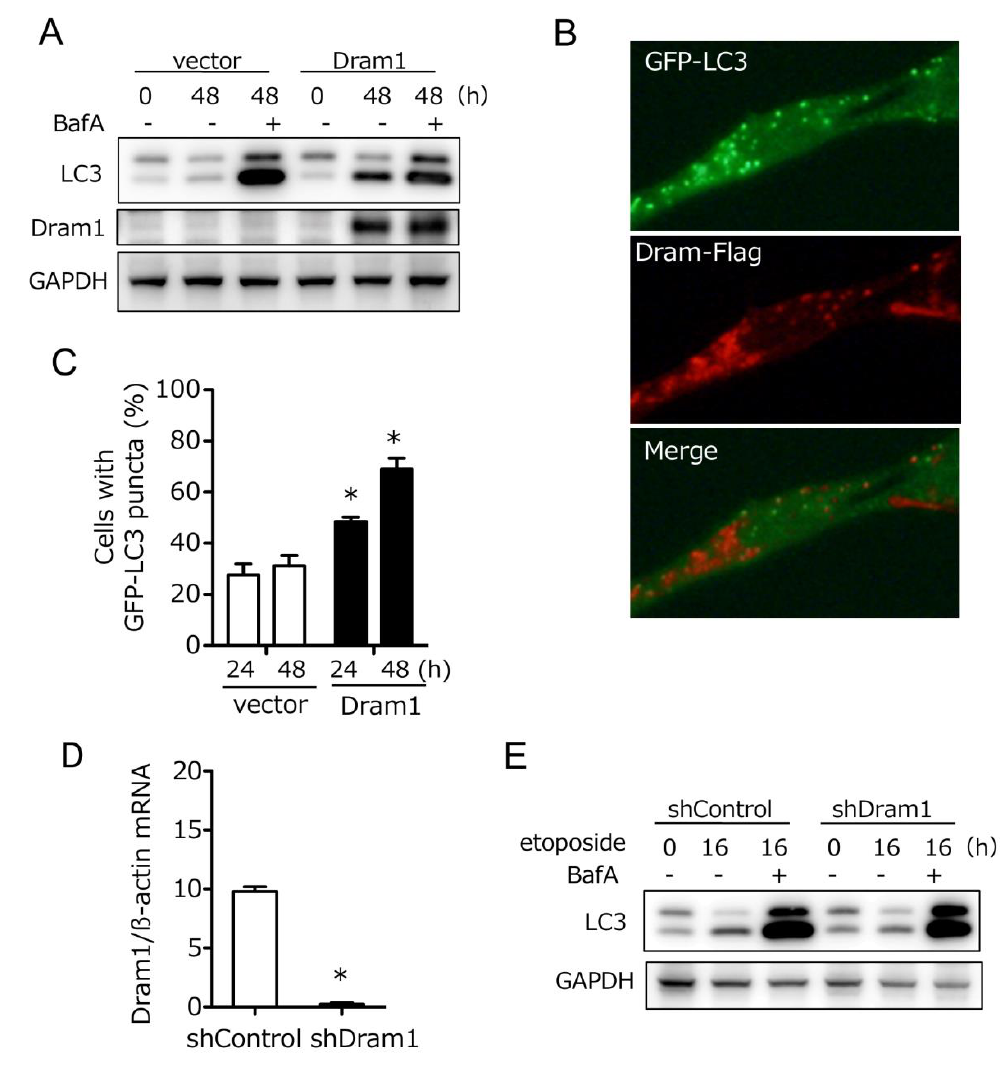
FIGURE 5: Dram1 is sufficient to induce conventional autophagy, but is not involved in etoposide-induced conventional autophagy . (A-C) Dram1 is sufficient to induce conventional autophagy. (A) WT MEFs were transfected with dram1-flag or a control vector for the indicated times in the presence or absence of bafilomycin A1 (BafA; 10 nM), and the expression of each protein was analyzed by western blotting. GAPDH was included as a loading control. (B, C) GFP-LC3-expressing WT MEFs were transfected with dram1-flag or control vector for the indicated times, and then immunostained with an anti-Flag antibody (red). GFP-LC3 signals are shown in green. Representative images at 24 h are shown in (B) . (C) The proportion of cells with LC3 puncta was calculated (n > 100 cells in each experiment). Data are shown as the mean + SD (n = 3 experiments). *p < 0.05 vs the value of “vector 24 h”. (D, E) Dram1 is not involved in etoposide-induced conventional autophagy. (D) shDram1-transfected and control WT MEFs were incubated with 10 µM etoposide for 8 h, and Dram1 ex- pression was assessed by qPCR using mRNA. *p < 0.05. (E) The indicated WT MEFs were treated with etoposide (10 µM) for the indicated times in the presence or absence of bafilomycin A1 (10 nM), and the expression of each protein was analyzed by western blotting. GAPDH was included as a loading OPEN ACCESS | www.cell-stress.com